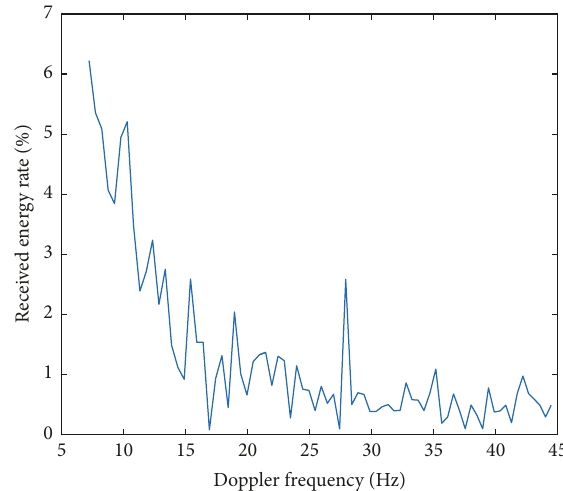
Figure 6: Simulation result when 𝑁 = 1000 .